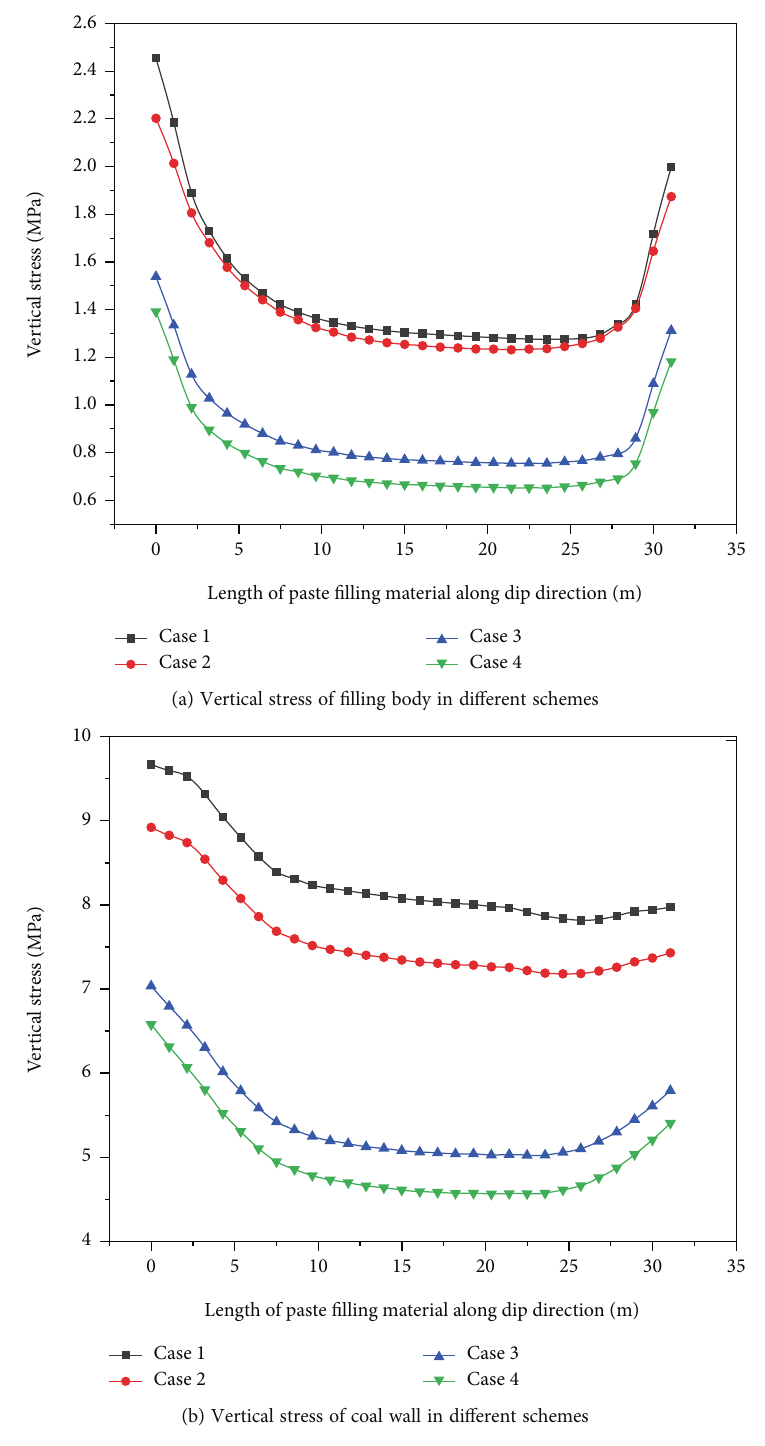
Figure 11: Vertical stress distribution of back fi ll and coal wall after